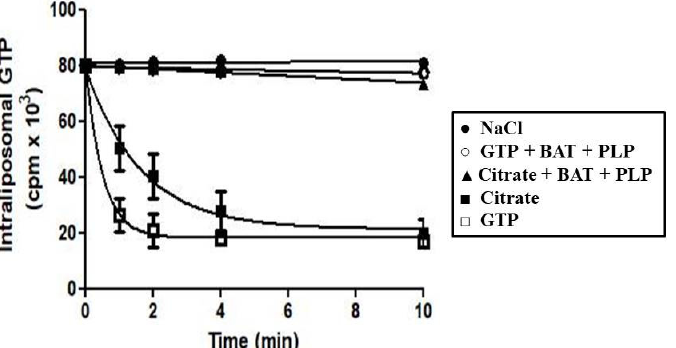
Figure 3. Efflux of GTP from proteoliposomes reconstituted with Ggc1p. The proteoliposomes were preloaded with 0.2 mM GTP, and then the internal substrate pool was made radioactive by carrier-mediated exchange equilibration. After 40 min, residual external radioactivity was removed by passing the proteoliposomes through a column of Sephadex G-75. The assay was started by adding 5 mM NaCl ( ● ), 5 mM GTP ( □ ), 5 mM citrate ( ■ ), 15 mM BAT, 30 mM PLP and 5 mM GTP ( ○ ) or 15 mM BAT, 30 mM PLP and 5 mM citrate ( ▲ ).